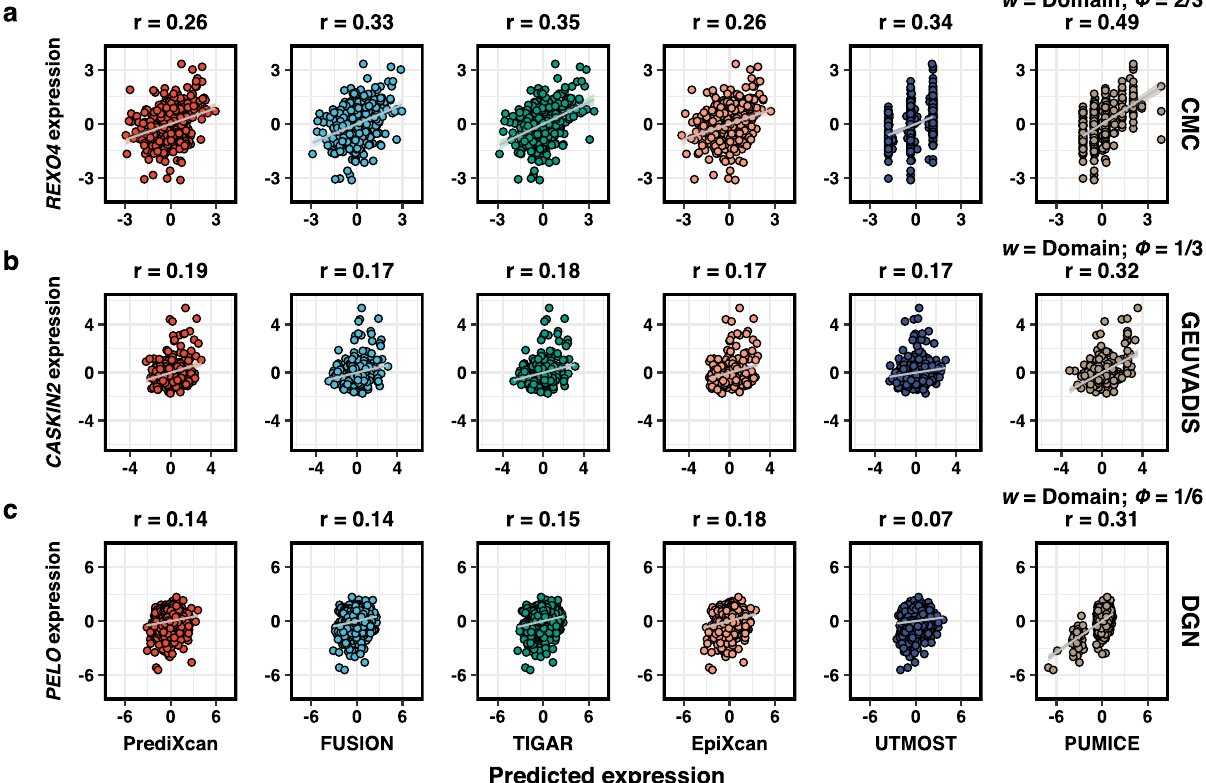
Fig. 3 Examples of well-imputed genes unique to PUMICE. Panel ( a ) displays prediction performance of REXO4 gene in CMC cohort. Panel ( b ) shows prediction performance of CASKIN2 gene in GEUVADIS cohort. Panel ( c ) shows prediction performance of PELO gene in DGN cohort. We show the selected window ( w ) and penalty factor ( ϕ ) associated with each PUMICE ’ s prediction model. Error bands represent 95% con fi dence